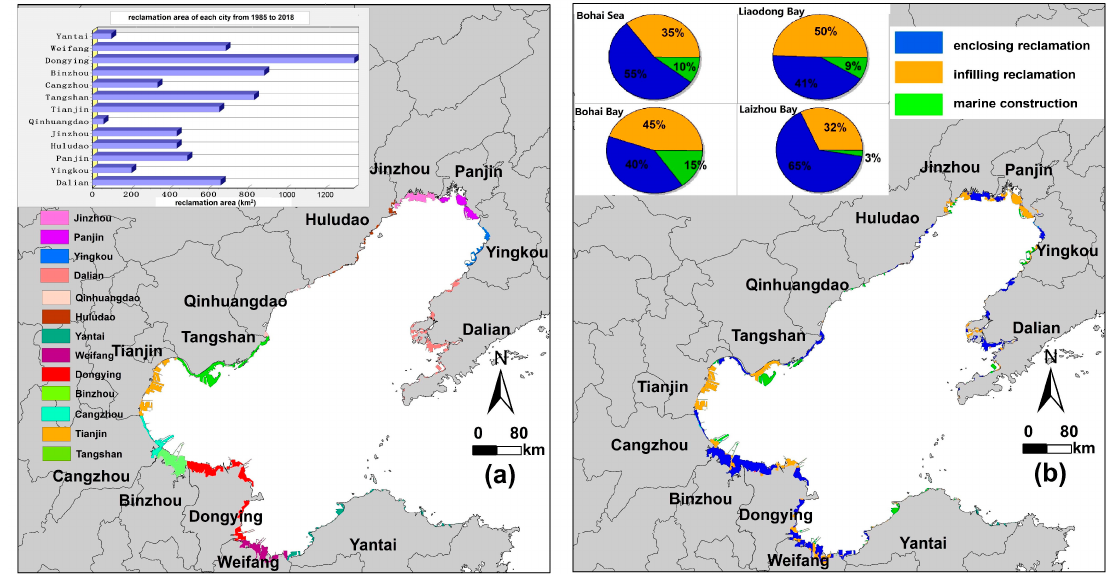
Figure 11. Reclamation area ( a ) and its utilization types ( b ) of 13 coastal cities from 1985 to 2018.